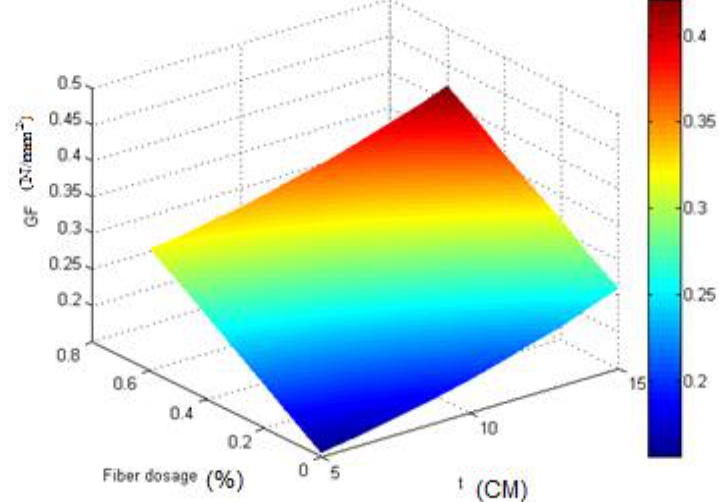
Figure 9. The relationship between G F , T , and Fiberdosage .